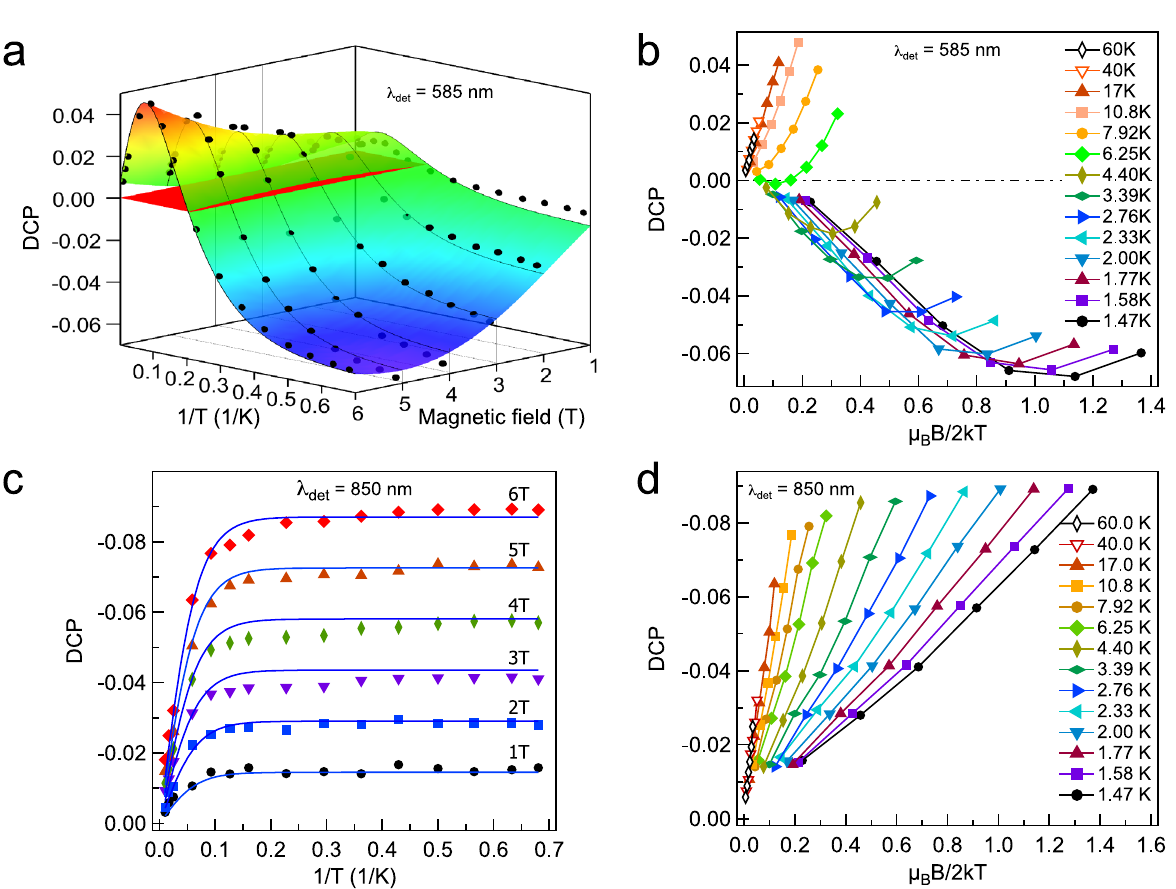
Figure 4. DCP data recorded at 585 and 850 nm upon excitation at 450 and 532 nm, respectively. ( a ) Data are shown as a function of temperature at fixed magnetic fields. Black dot markers— experimental data, rainbow- coloured surface—theoretical DCP calculated using parameters from the data fit to Eq. (1) with i = 2 . The red colour plane indicates the zero polarization level. b) Magnetic field dependence of DCP at fixed temperatures. ( c ) Data recorded at 850 nm are shown as a function of temperature at fixed magnetic fields. Markers— experimental data, lines— theoretical DCP calculated from the data fit to Eq. (1) with i = 1 . ( d ) DCP data shown as a function of magnetic field at fixed